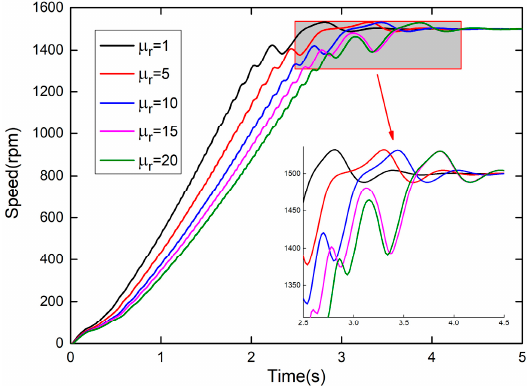
Figure 20. Speed curve with different MSWs.